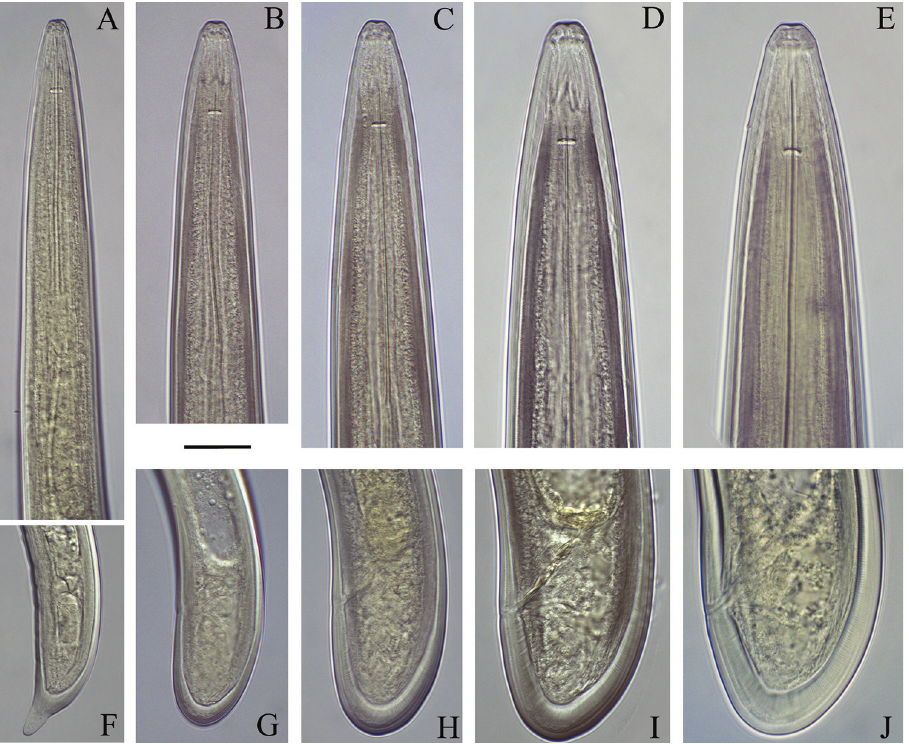
Figure 6. Longidorus polyae sp. n. A–E anterior end of first- to fourth-stage juveniles and female F–J tail of first- to fourth- stage juvenile and female. Scale bar: 20